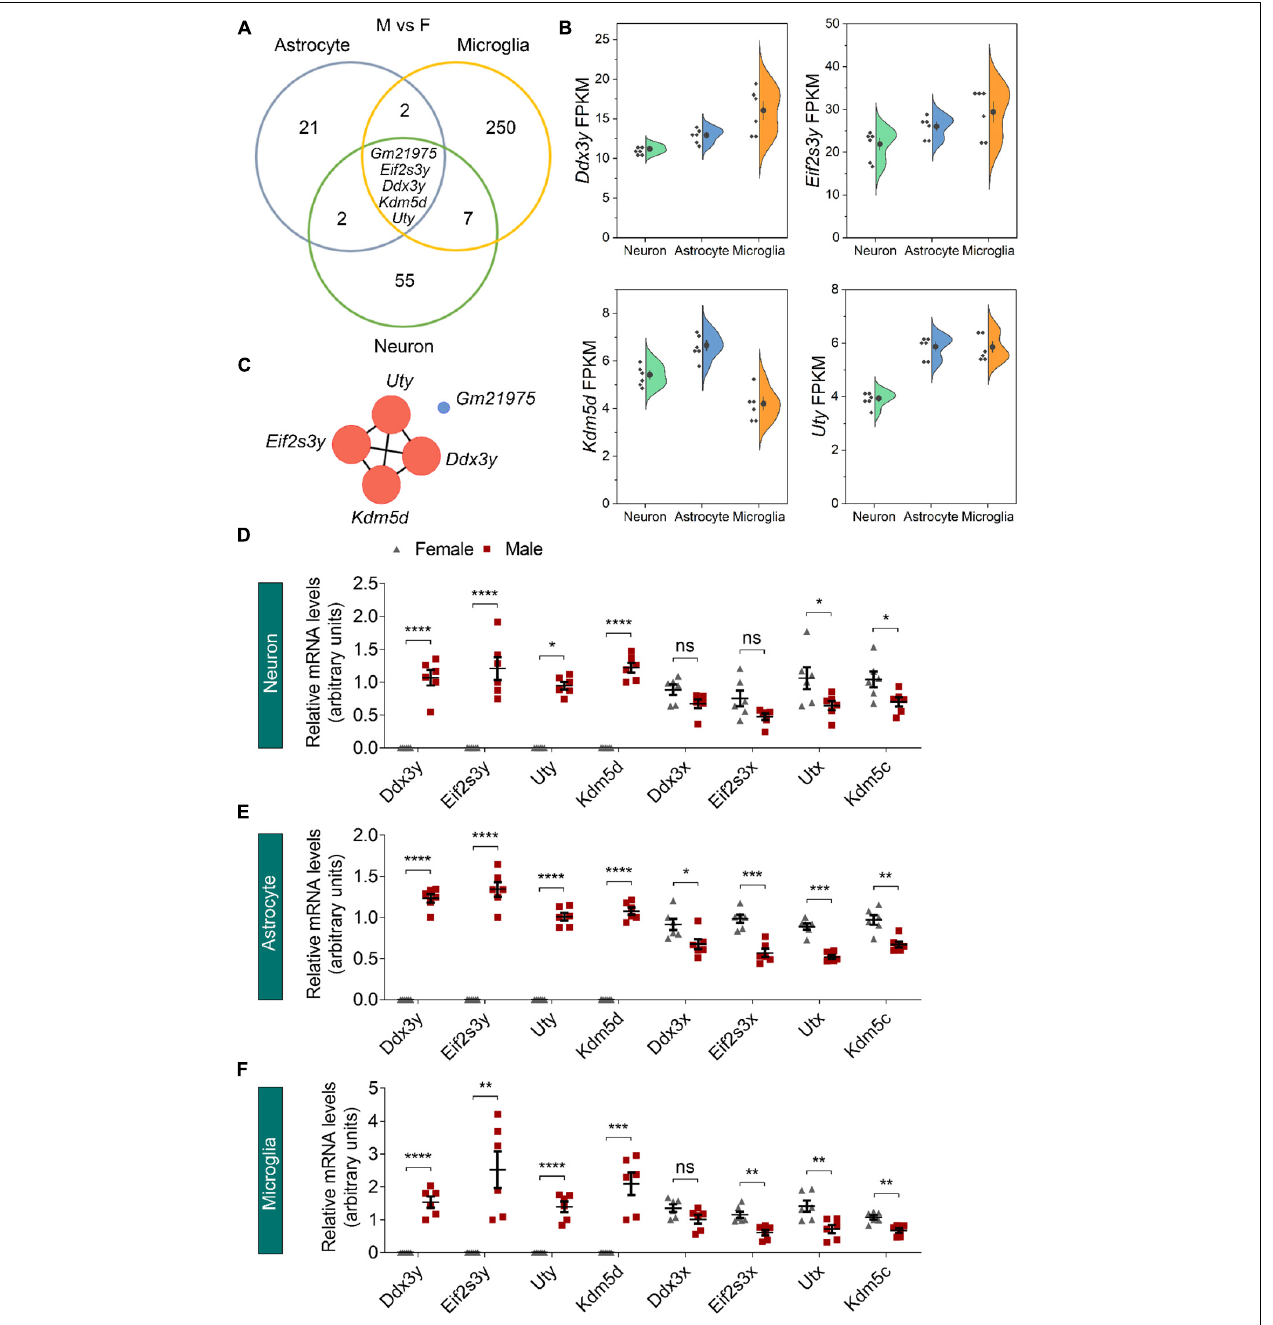
FIGURE 3 | Identification of sexually dimorphic genes shared by different neural cell types. (A) Venn diagram analysis revealed five DEGs (male vs. female, M vs. F) shared by neurons, astrocytes, and microglia. (B) RNA sequencing identified Ddx3y , Eif2s3y , Kdm5d , and Uty expression levels (represented using FPKM) in male neurons, astrocytes, and microglia. n = 6 per group. (C) Protein-protein interaction analysis depicted a robust interaction within the four Y-linked genes: Ddx3y , Eif2s3y , Kdm5d , and Uty. (D–F) Relative mRNA levels of the four Y-linked genes and respective homologous genes on the X chromosome in neurons (D) , astrocytes (E), and microglia (F) were determined by qRT-PCR and compared between male and female samples. n = 6 per group. Unpaired t -test. * p < 0.05, ** p < 0.01, *** p < 0.001, **** p < 0.0001, ns, not significant.